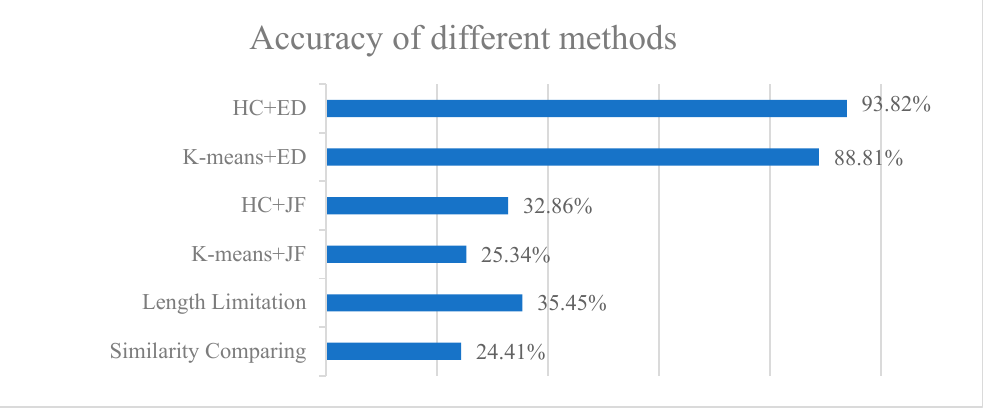
Figure 4. The proportion of noise screened by di ff erent methods to the total noise.